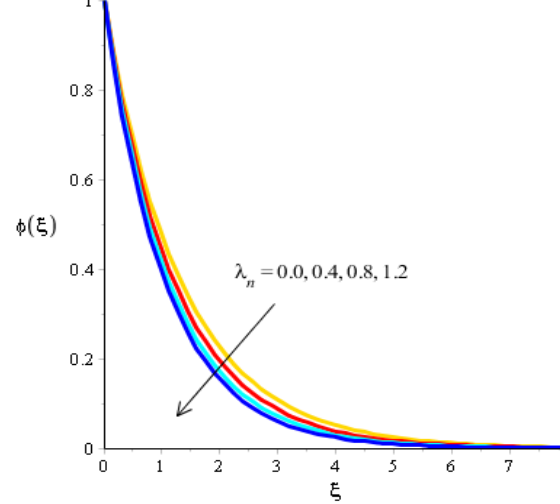
Figure 12. Analysis of concentration curves versus λ n .